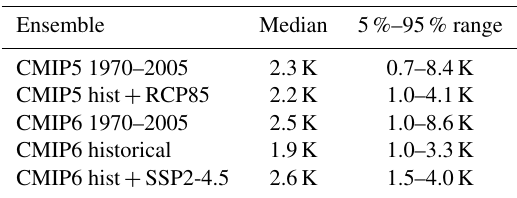
Table 2. Emergent constraint on ECS depending on choice of en- semble and